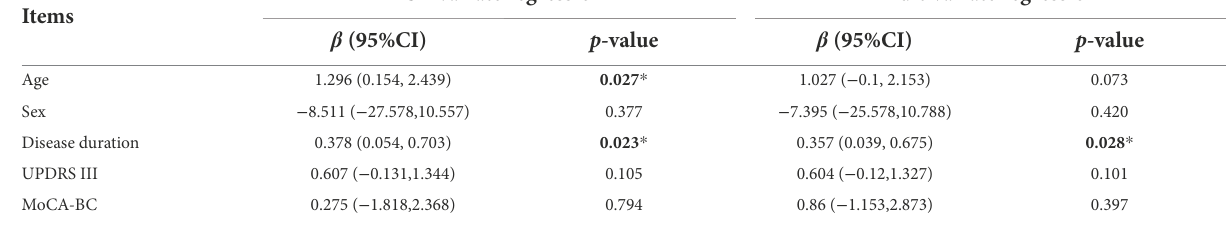
TABLE 3 Independent associated factors of saccadic latency in de novo PD